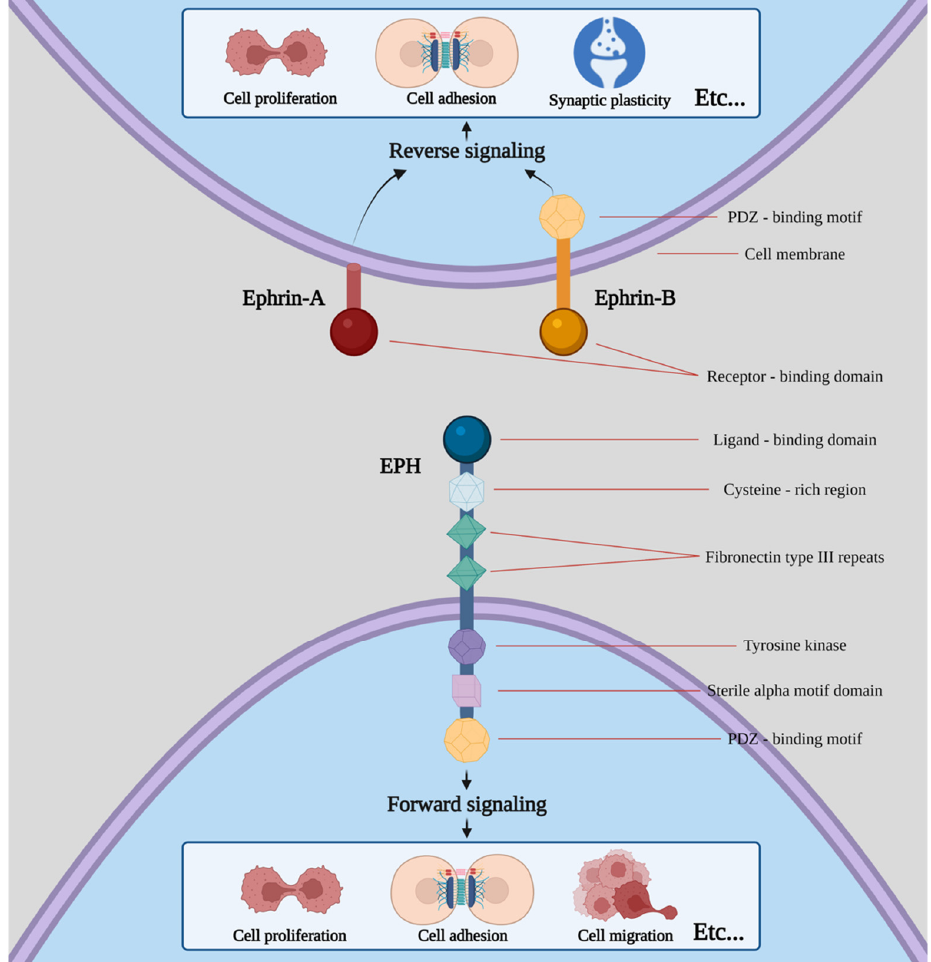
Figure 1. Structure of EPHs/ephrins and schematic presentation of forward and reverse signaling. Etc. means that both procedures can induce a plethora of effects apart from the ones shown in the picture, including cell segregation, border sharpening, cell repulsion and neurite outgrowth as well as cell survival and maturation.